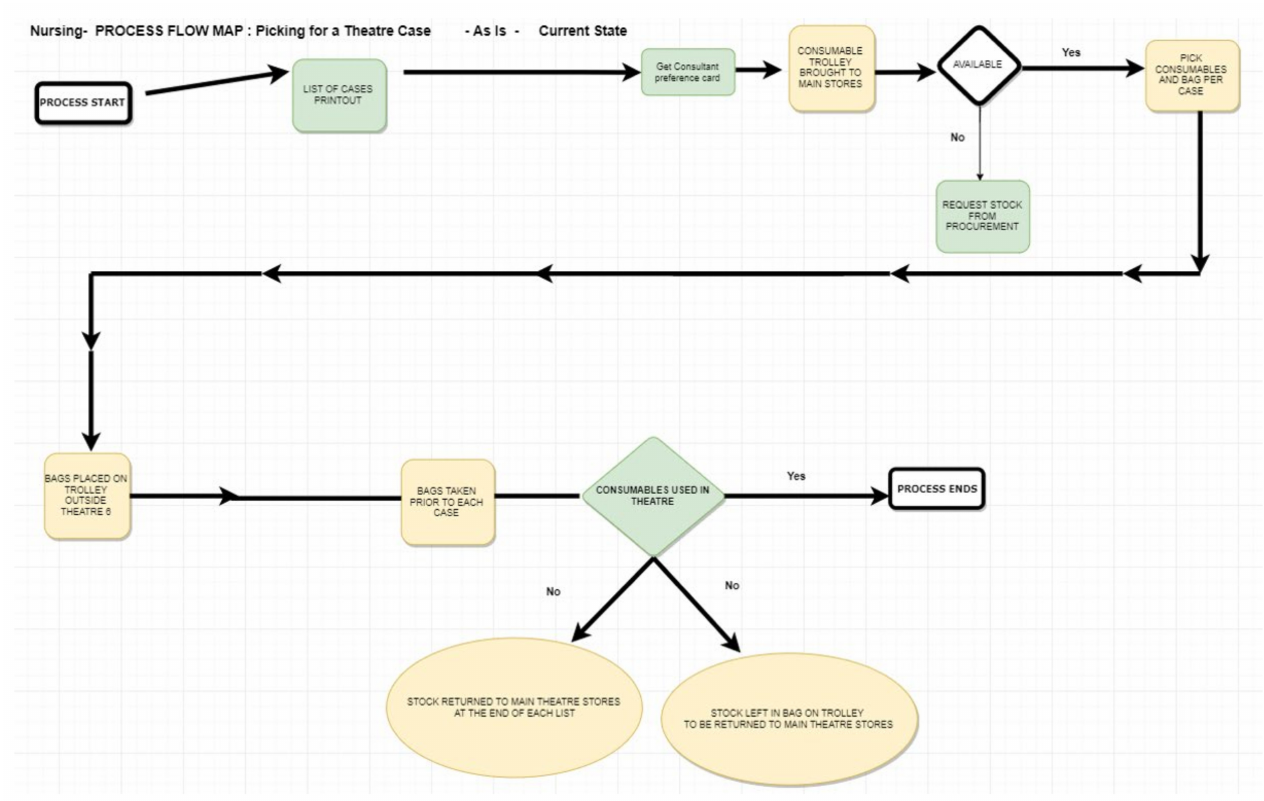
Figure 3. OR Nursing Staff Process for Picking and Returning